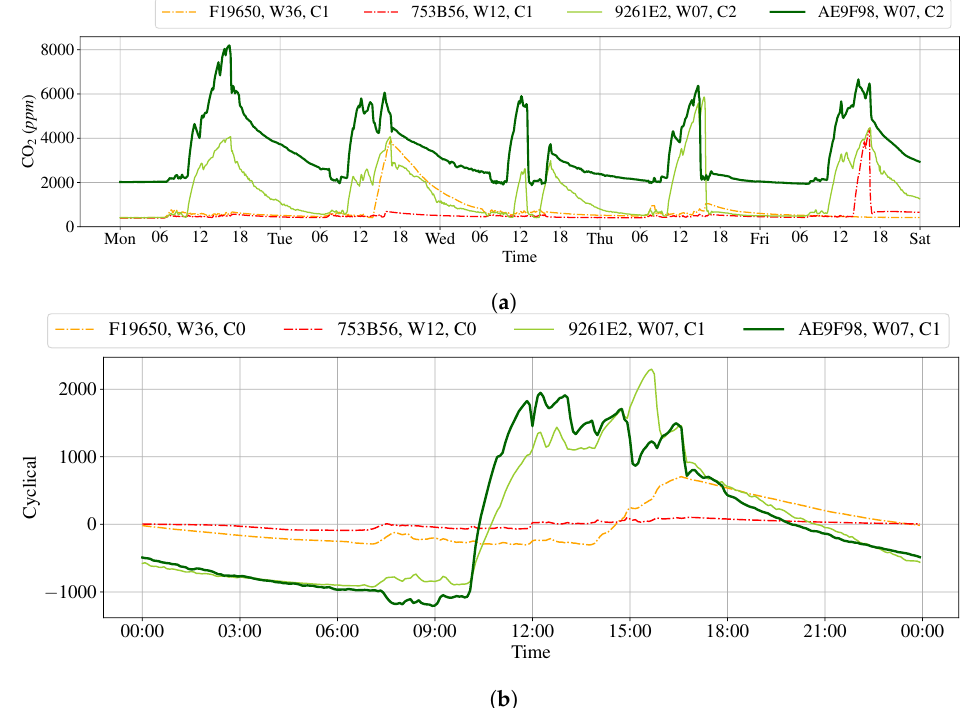
Figure 23. Results of different clustering techniques. ( a ) Raw data; ( b ) Cyclical components.